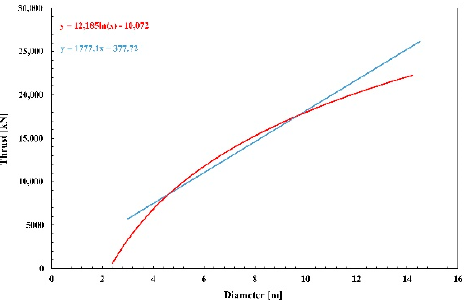
Figure 22. Trend of the thrust vs. the diameter based on data collected from the analysis of open TBMs. In red, the experimental model proposed in this study; in blue, the model proposed by [42]. However, with the same diameter, the thrust values are very similar, and the discrep- ancy is probably related to the different amount of data